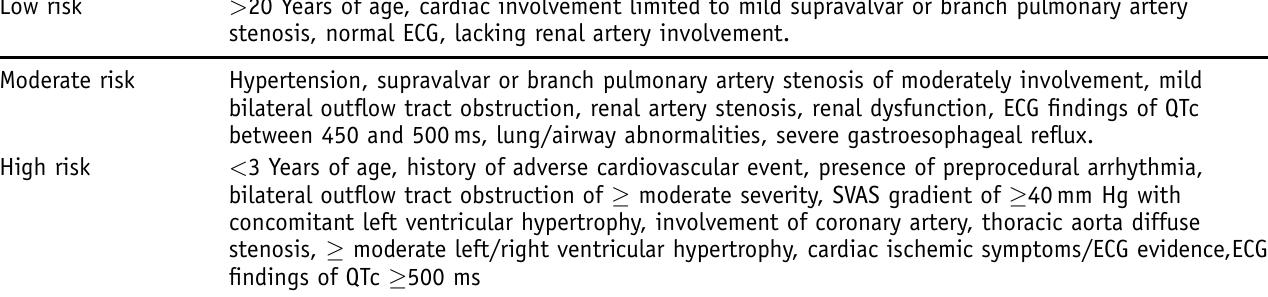
Table V. Risk strati fi cation for WBS undergoing procedures under general anesthesia. Low risk > 20 Years of age, cardiac involvement limited to mild supravalvar or branch pulmonary artery stenosis, normal ECG, lacking renal artery